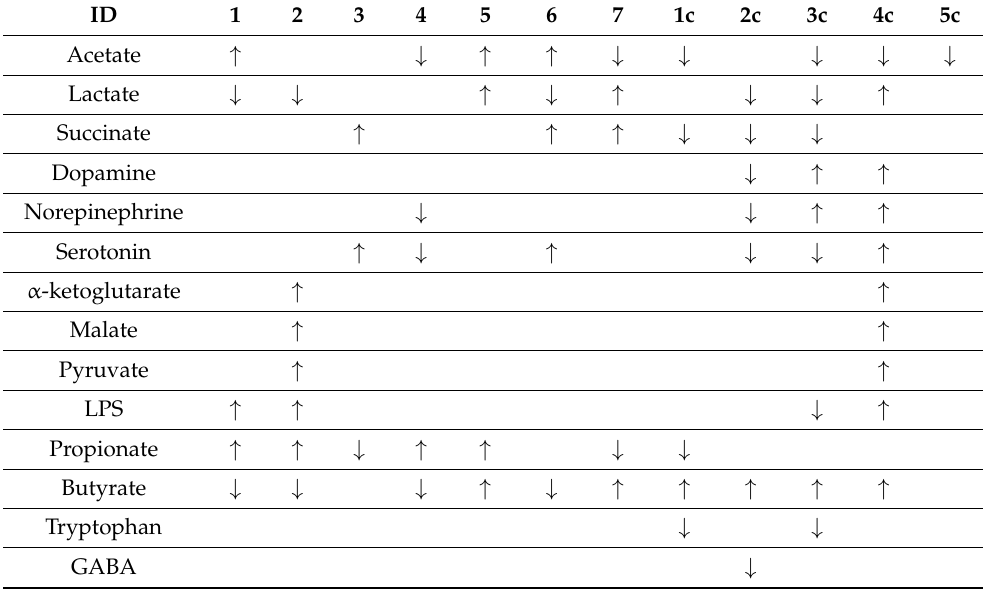
Table 4. Correspondence between altered microbiota families/genera and nervous-related metabolite levels. Differential abundances of bacterial families/genera leads to corresponding alterations of related metabolites acting as intermediate in neurophysiology. Considered metabolites only refer to microbiota biosynthesis, and they are retrieved from MACADAM database and literature. “ ↑ ” = over-production. “ ↓ “ = down-production. “[empty space]” = no expression